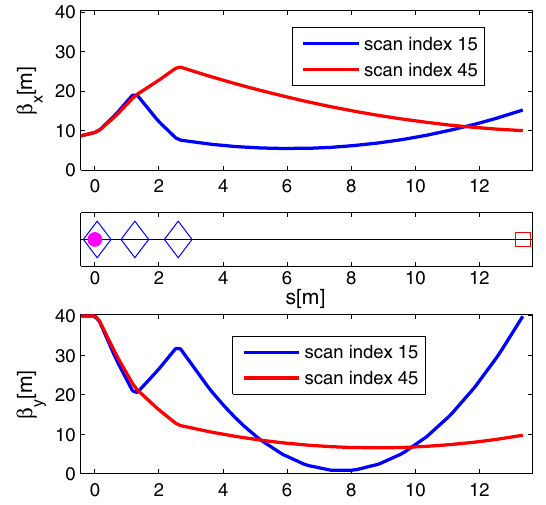
FIG. 3. β functions along the measurement lattice for two selected cases (see Fig. 2). The center plot shows the position of the quadrupoles (blue diamonds), the reconstruction point (magenta dot), and the measurement location (red rectangle). The design Twiss values at the reconstruction point are the following: β x ¼ 9 . 51 m, α x ¼ − 1 . 03 , β y ¼ 40 . 02 m, α y ¼ − 0 . 02 .